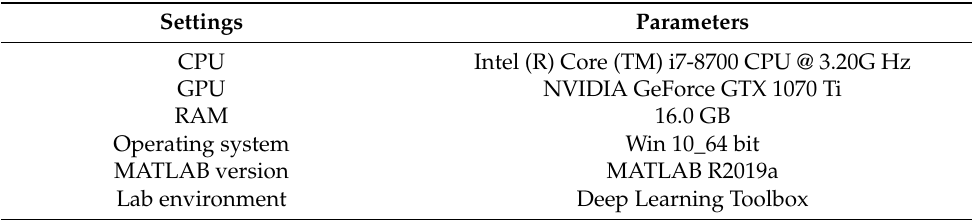
Table 4. Parameters of the experimental environment.